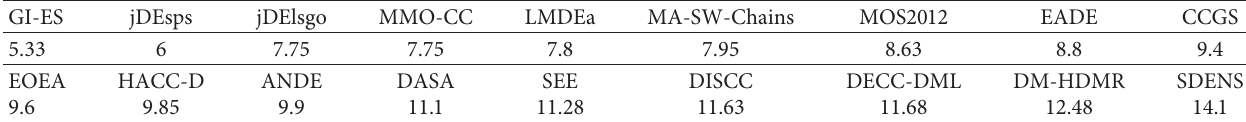
Table 10: Ranking of GI-ES and state-of-the-art algorithms according to Friedman test using CEC2010. GI-ES jDEsps EOEA